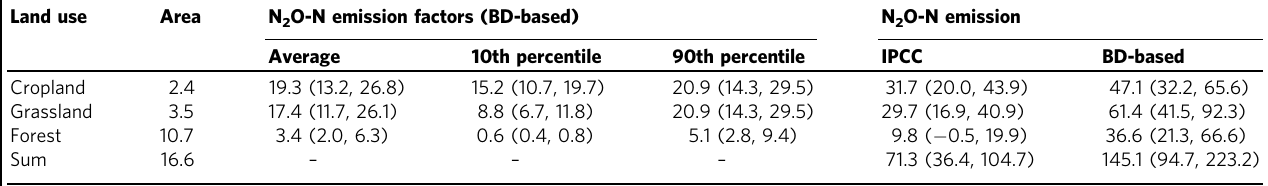
The parentheses indicate 95% con fi dence